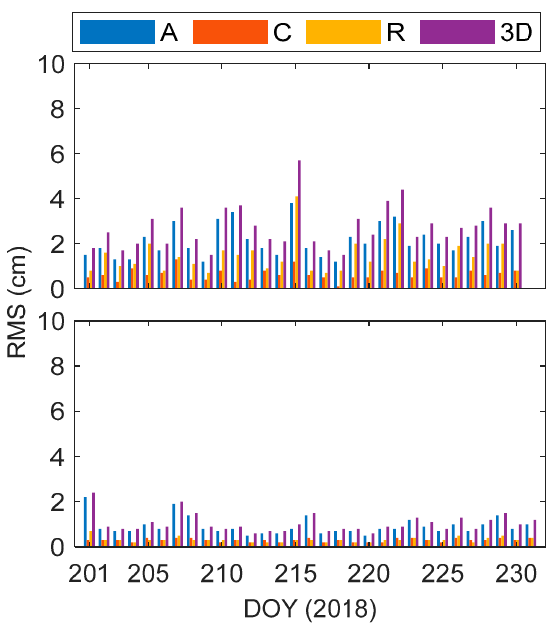
Figure 13. Orbit overlap differences for combined POD ( top panel ) and orbit differences between combined POD and GPS-based POD ( bottom panel ).